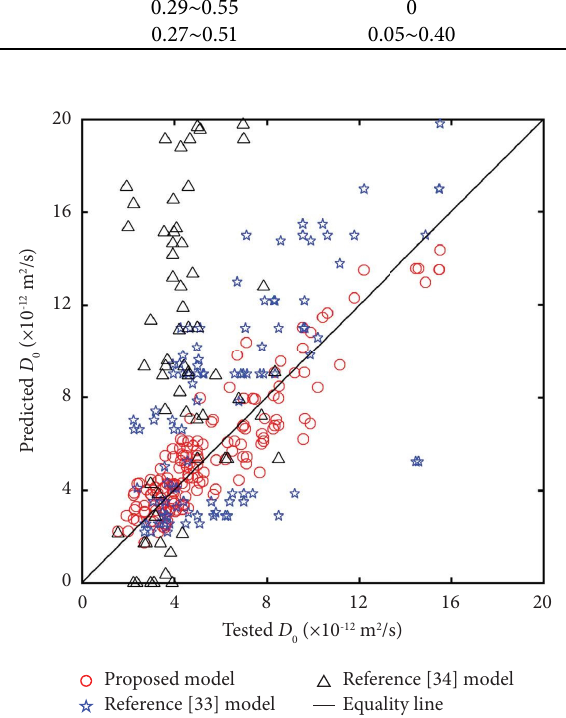
Figure 2: Comparison of proposed models with experimental data. Table 3: Te optimal estimation for a .